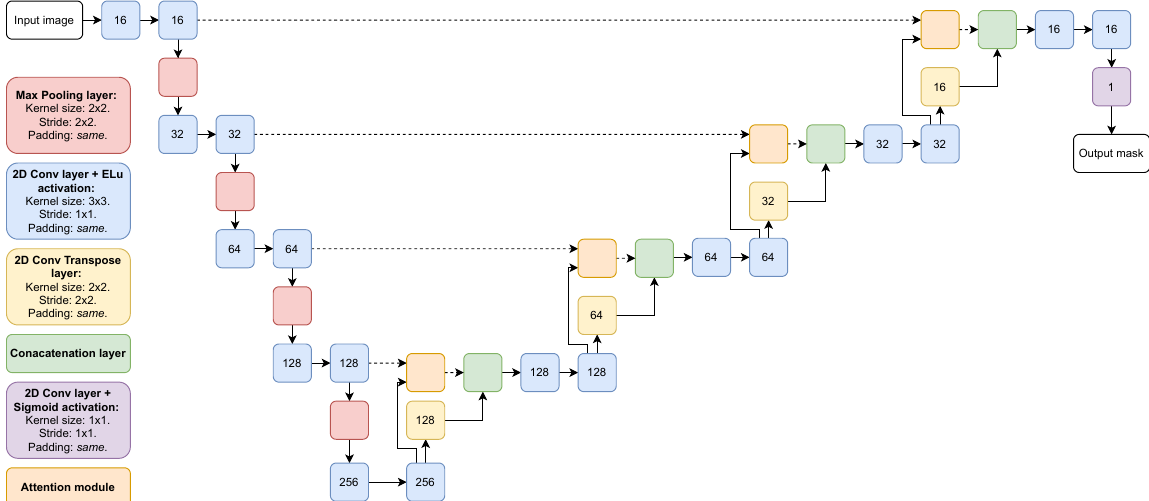
Figure 19. In-detail structure of the model proposed by Akhloufi et al. [38] with the inclusion of AG modules. The numbers inside the squares represent the number of filters in the corresponding layer.